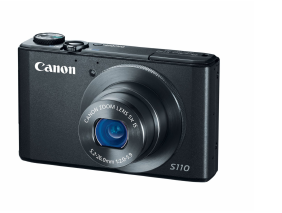
Figure 8: Velodyne HDL- 32E LiDAR